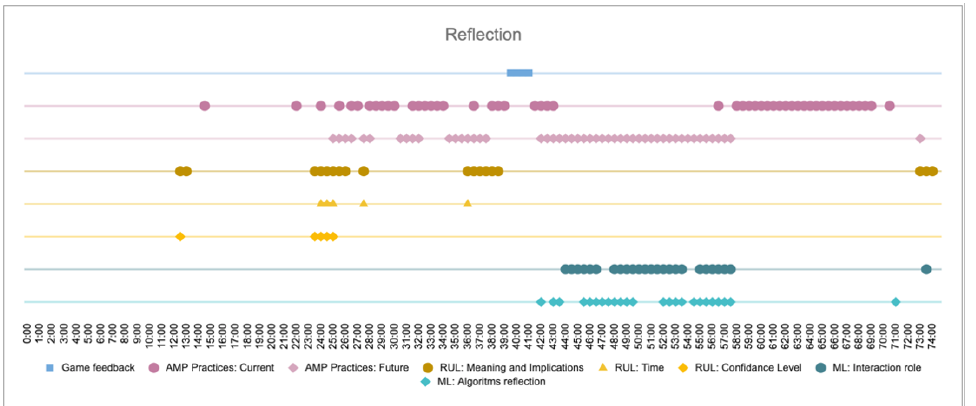
Figure 6. Reflections on the conversation during the experiment.